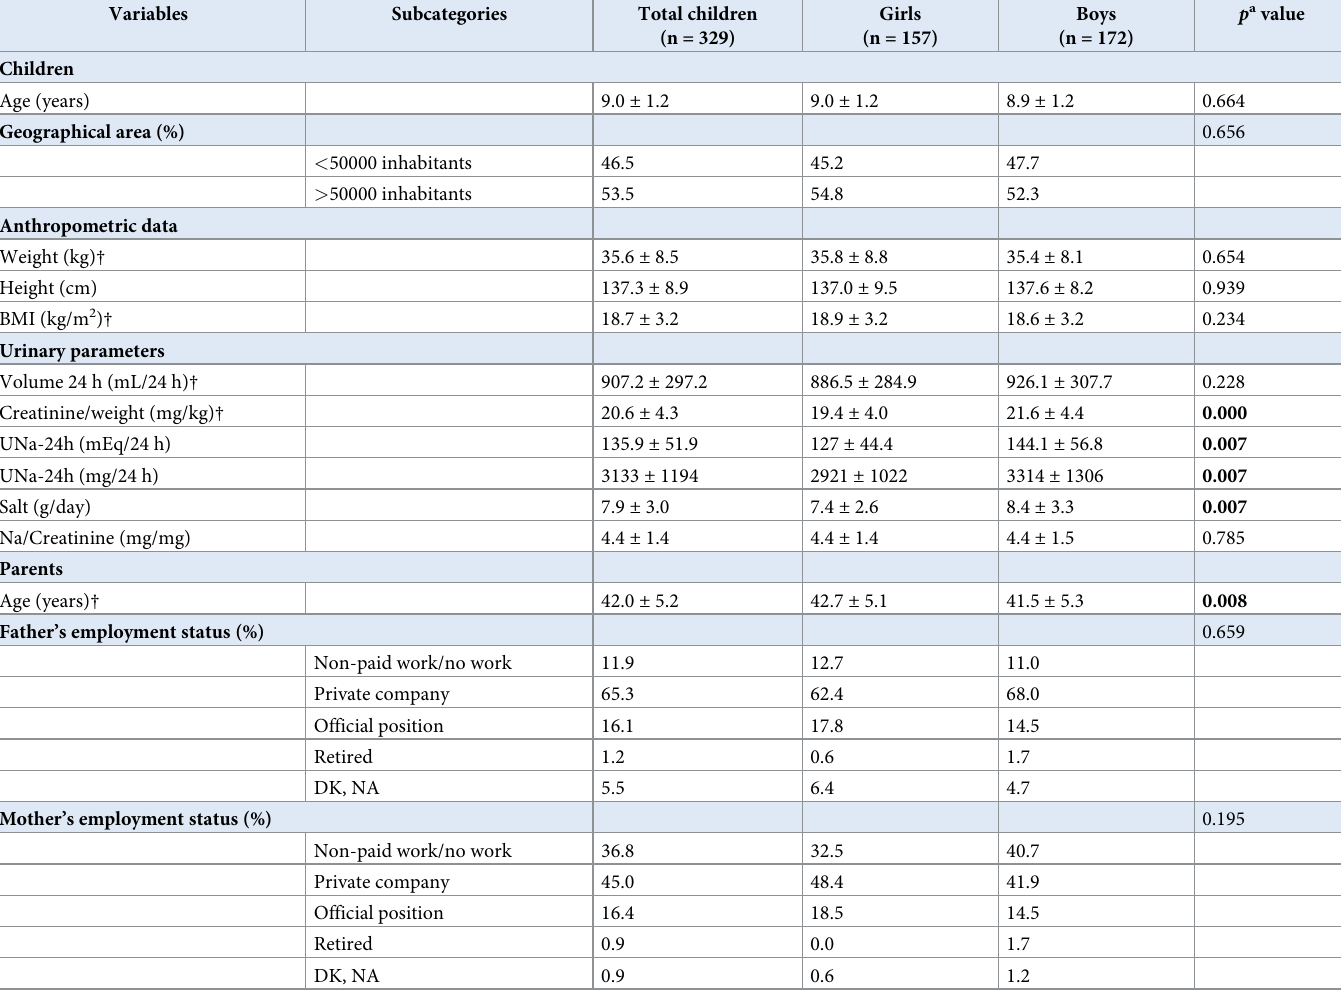
Table 1. Participants’ demographic, anthropometric, and urinary parameters by children’s sex (mean ± SD or